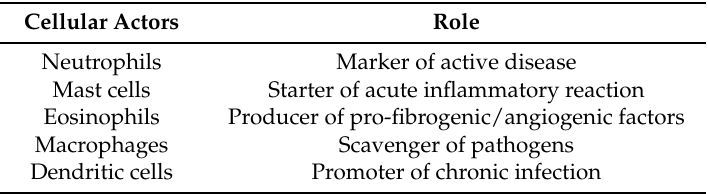
Table 1. Cellular players of innate immunity in H. pylori